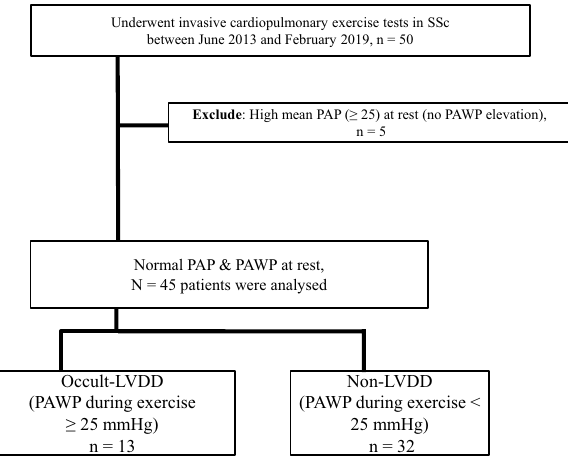
Figure 1. Flow chart of patients with SSc who underwent cardiopulmonary exercise testing with right heart catheterization. LVDD, left ventricular diastolic dysfunction; PAP, pulmonary artery pressure; PAWP, pulmonary artery wedge pressure; PH, pulmonary hypertension; SSc, systemic sclerosis.